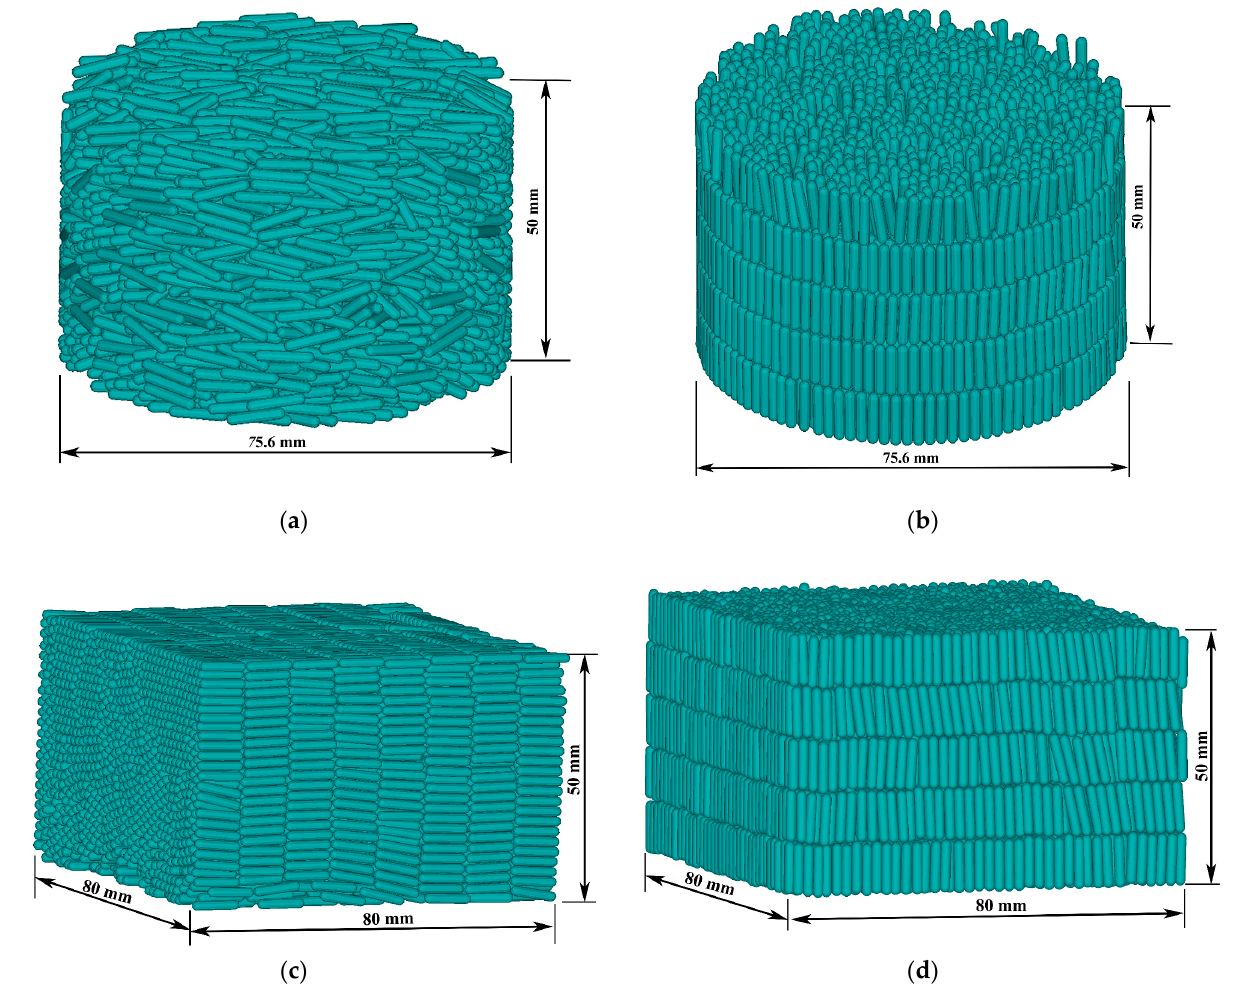
Figure 18. Diagram of regular configuration of elongated particles ( L p = 10 mm): ( a , b ) are lateral arrangement and vertical arrangement in the cylindrical cup; ( c , d ) are the lateral arrangement and vertical arrangement in the cuboid cup.